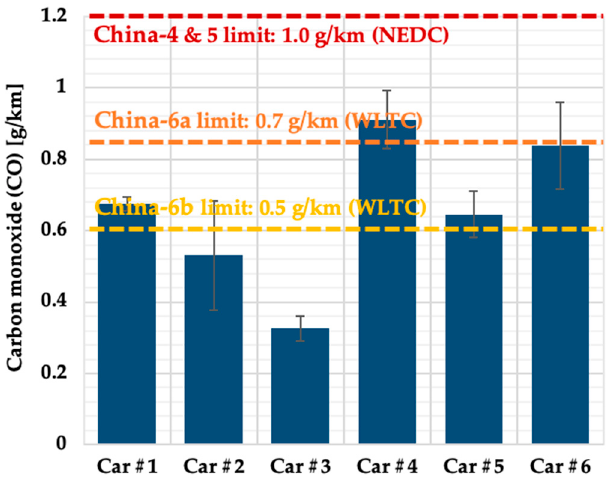
Figure 2. CO emissions from the in-use methanol taxis.